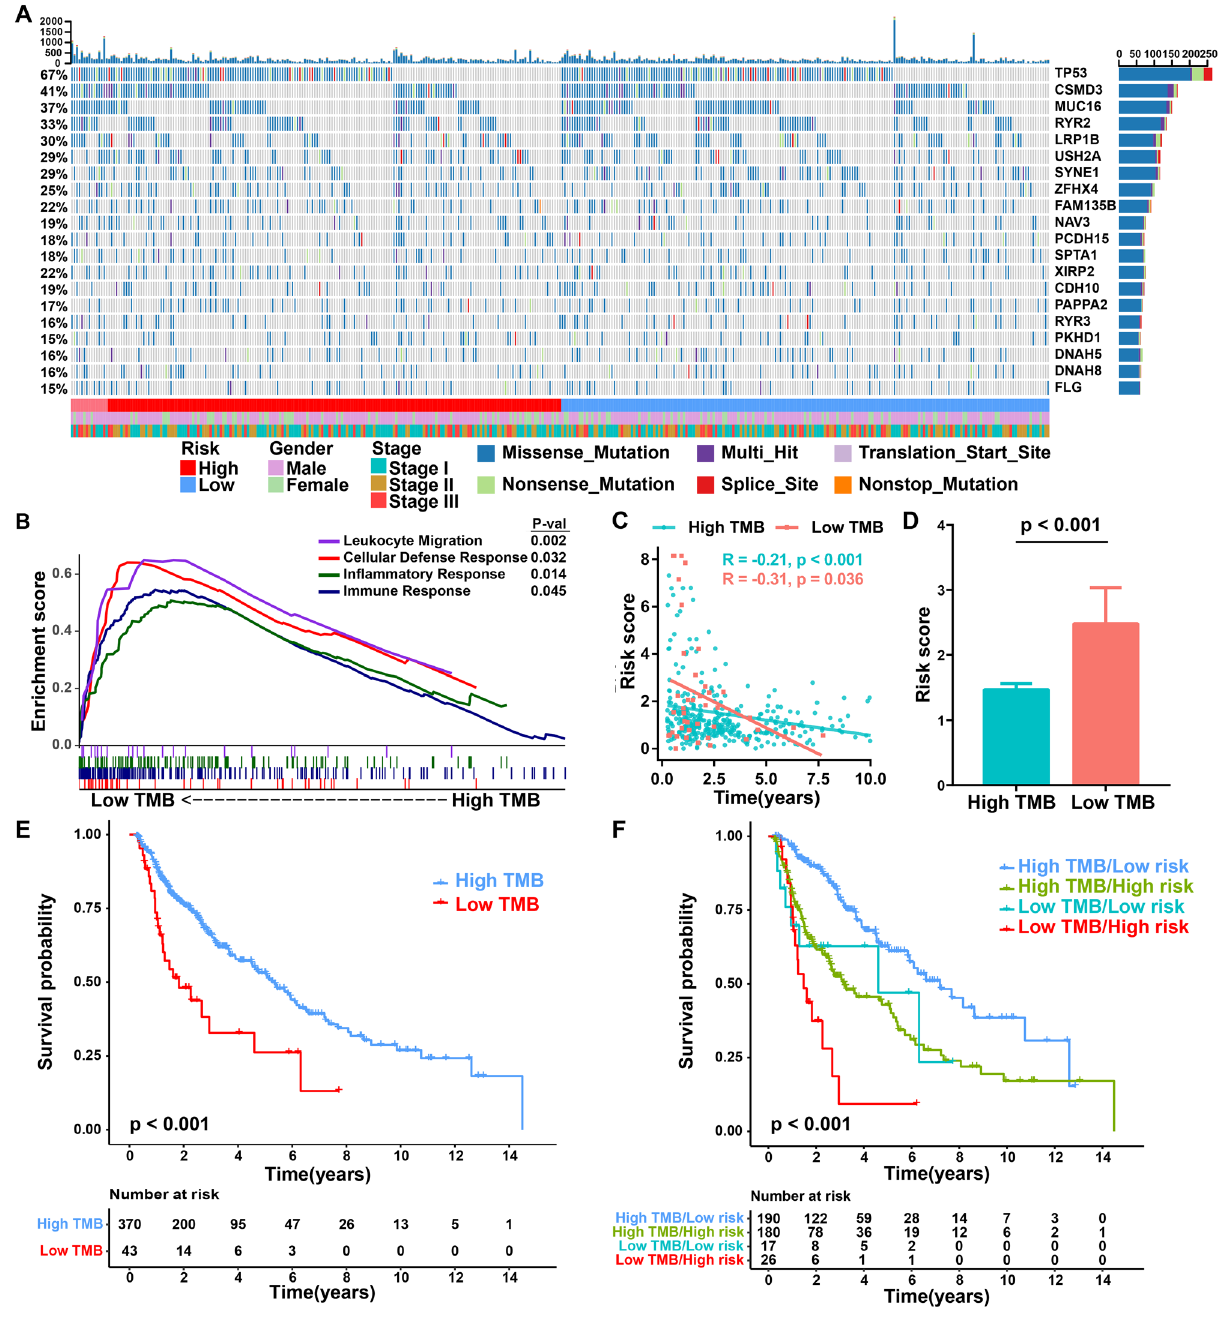
Figure 4. Relationship between mutational signature and the IPM. ( A ) Stacked plots of mutational frequency in individual tumors (histogram, top), mutations in the top 20 genes (tile plot, middle), their mutational counts (histogram, right) and mutational types (bottom). ( B ) GSEA enrichment plots of immune-related phenotype in low TMB patients compared with that in high TMB patients. ( C ) Correlation analyses between survival time and risk score based on TMB level. ( D ) Risk score distribution in high- and low-TMB groups. Data are presented as mean ± SEM. ( E ) Kaplan–Meier curves showing favorable survival in patients with high TMB. ( F ) Kaplan–Meier curves showing significantly prolonged survival in patients with high TMB and low risk compared with patients with low TMB and high